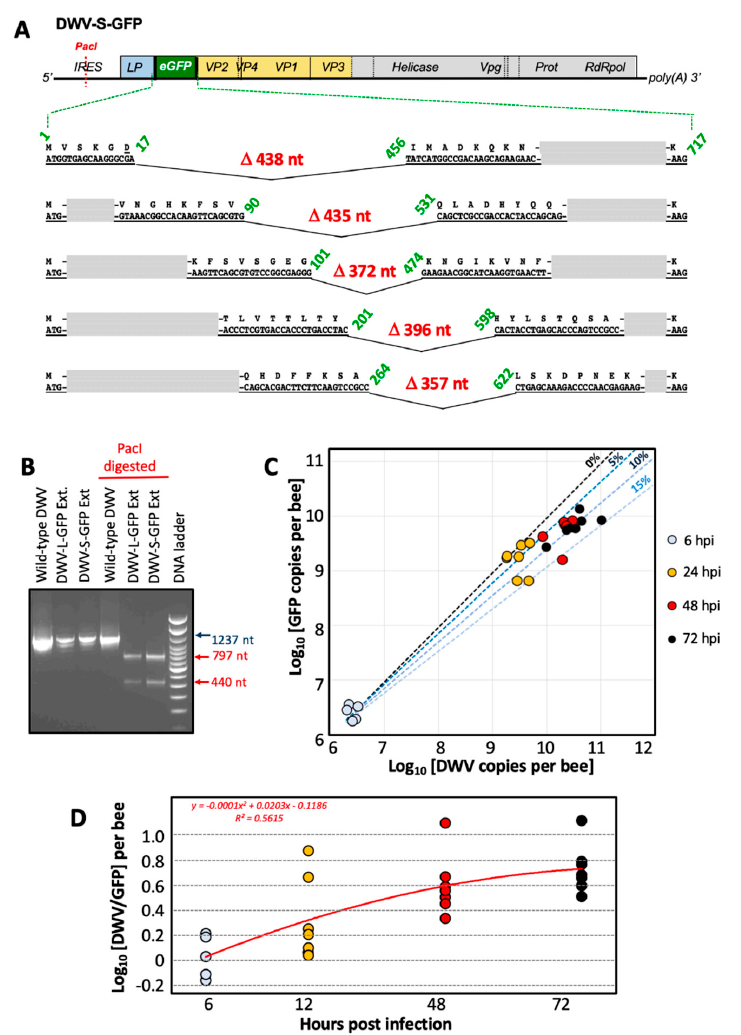
Figure 7. Genetic stability of the GFP-tagged DWV. ( A ) Deletions of the GFP-coding sequence in the DWV-S-GFP progeny accumulated in a honey bee pupae 72 h post injection (hpi) with the virus extract. The RT-PCR fragments were generated using the primers flanking GFP insert and cloned into a plasmid vector. Shown are the nucleotide sequences and the corresponding amino acid sequences adjacent to the deletion breakpoints, the numbers indicate the positions of the GFP sequence joined in the deletants and the sizes of deletions. The integrity of the viral ORF was restored in the case of all deletions. ( B ) Analysis of the 5 ′ RT-PCR region. The RT-PCR fragments corresponding to the 5 ′ of DWV were produced using the combined samples of the pupae injected with DWV-L-GFP and DWV-S-GFP extracts at 72 hpi, pupae with the wild-type DWV was used as a control. The RT-PCR fragments were digested with Pac I restriction enzyme, the site was present only in the cDNA clone-derived DWV. ( C ) Copy numbers of DWV ( X -axis) and GFP ( Y -axis) RNA targets revealed by RT-qPCR in individual honey bee pupae 6, 24, 48 and 72 hpi with the virus extracts containing 107 genome equivalents of DWV-S-GFP. Dashed lines indicate projected ratios of DWV and GFP with 0%, 5%, 10% and 15% probability of generation deletion mutant during genome replication cycle starting from the average copy numbers observed at 6 hpi. ( D ) Temporal dynamics of the ratio between the copy number of DWV and GFP in the honey bee pupae infected with DWV-S-GFP. Log-transformed DWV/GFP ratio per individual pupae stratified according to time post inoculation. Regression analysis revealed a significant relationship ( R2 = 0.5614) between the time after infection and the DWV/GFP ratio. Red line—quadratic regression curve over time, R2 = 0.5615.